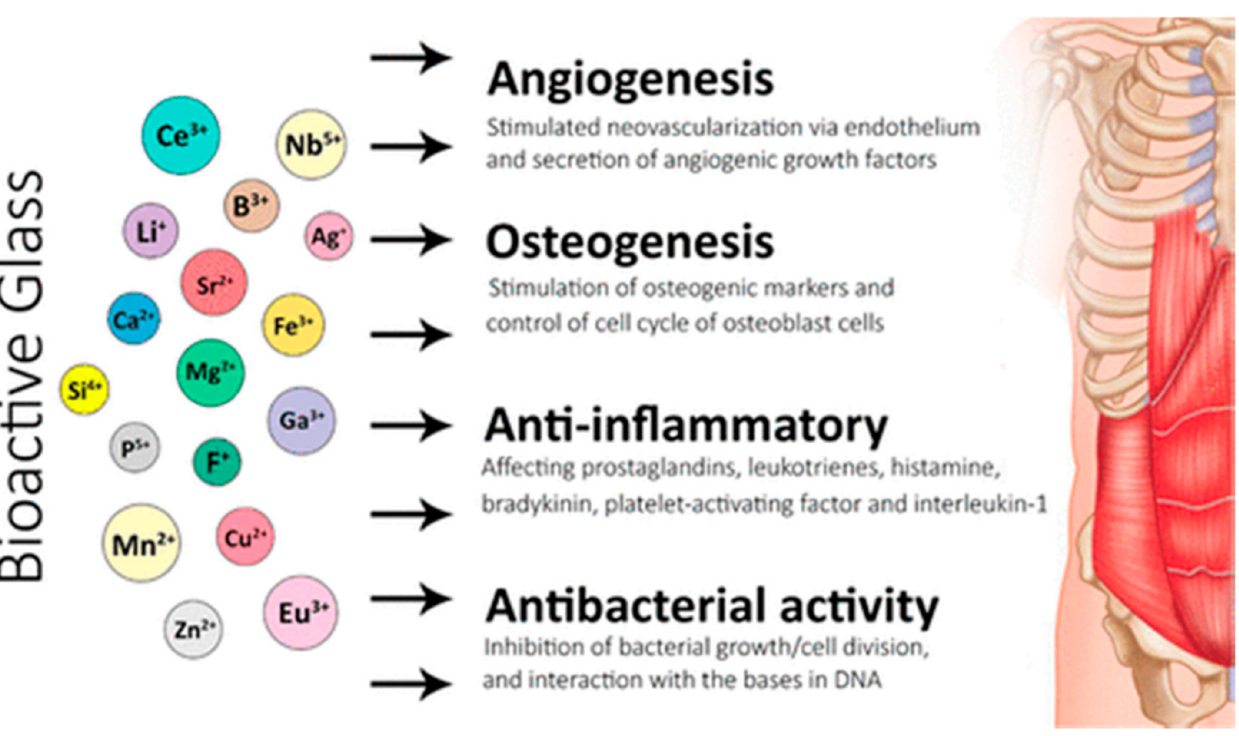
Figure 3. Applications of bioactive glasses in angiogenesis, osteogenesis, and anti-inflammatory and anti-bacterial activities [38] .